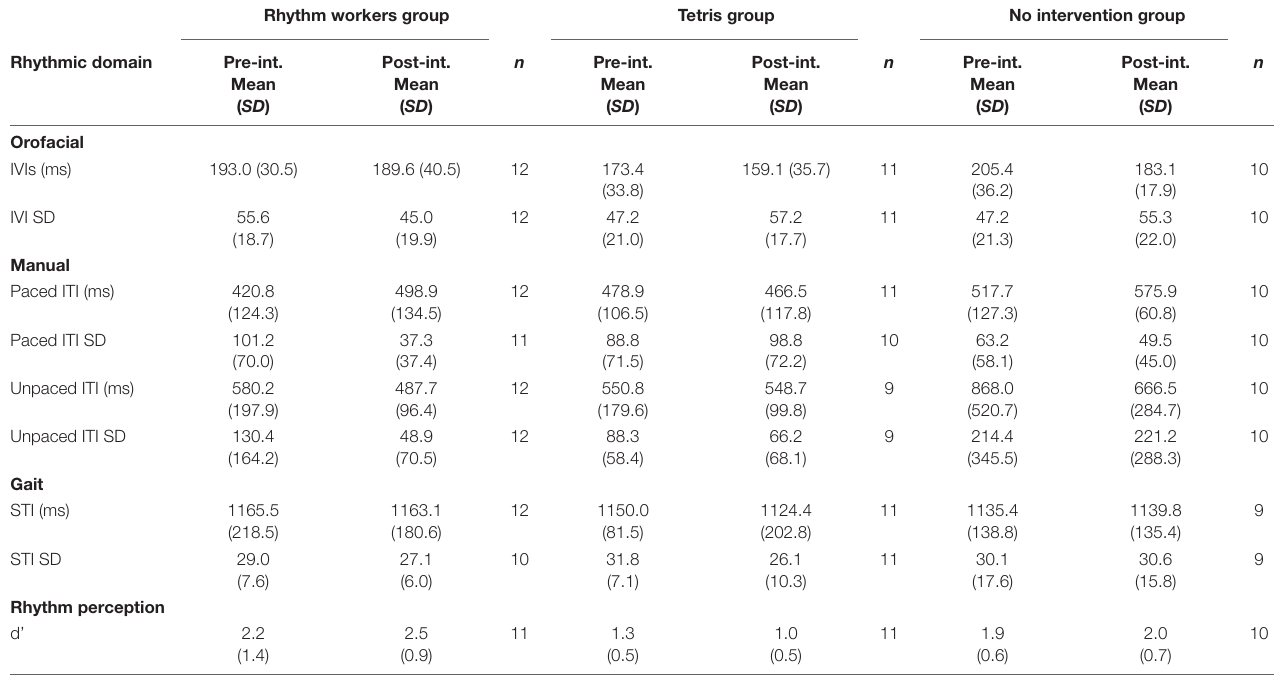
TABLE 2 | Rhythm performance for PD patients in the two experimental groups ( Rhythm Workers and Tetris ) and in the no intervention group. Rhythm workers group Tetris group No intervention